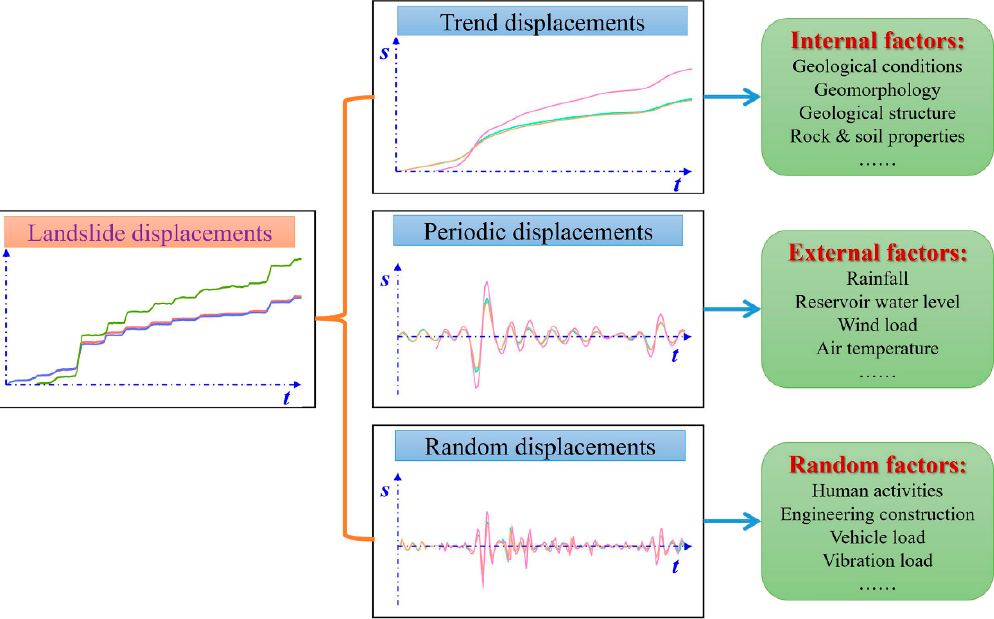
Figure 10. Relationship among trend displacement, periodic displacement, and random displacement.